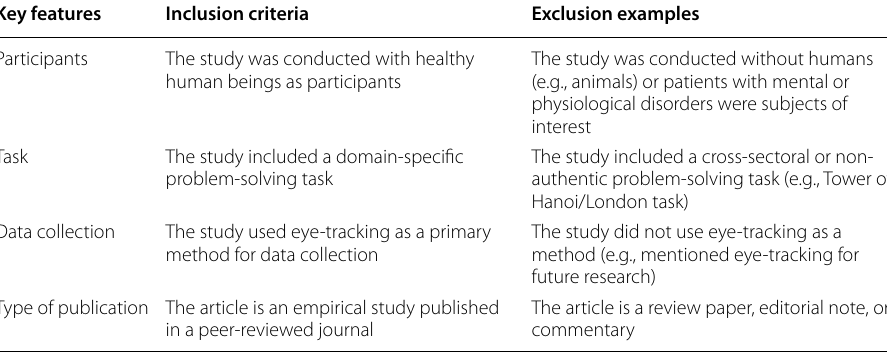
Table 1 Key features, inclusion criteria, and exclusion examples Key